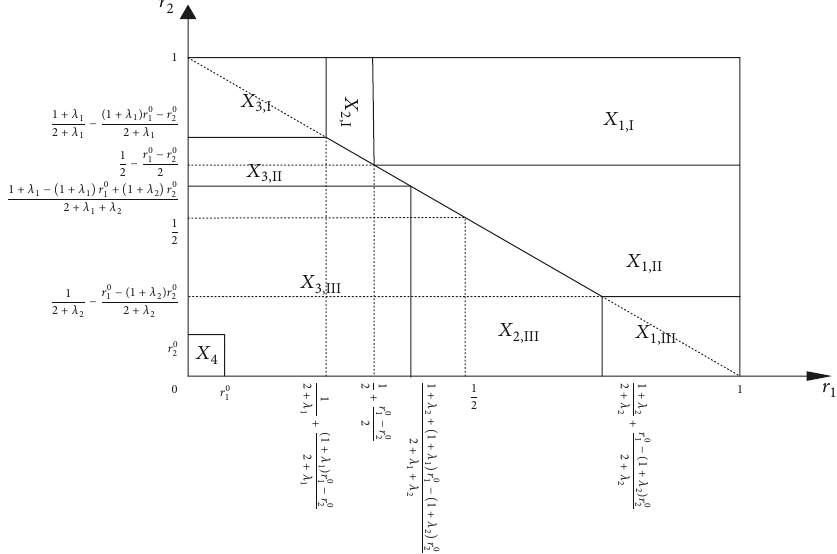
Figure 6: The equilibrium partitions for 𝛿 󳨀→ 1 , with 𝑟 0 1 < 𝑟 0 2 and 𝜆 1 < 𝜆 2 < 𝜆 1 (1 − 2𝑟 0 1 ) + 2(𝑟 0 2 − 𝑟 0 1 )/(1 − 2𝑟 0 2 ) .